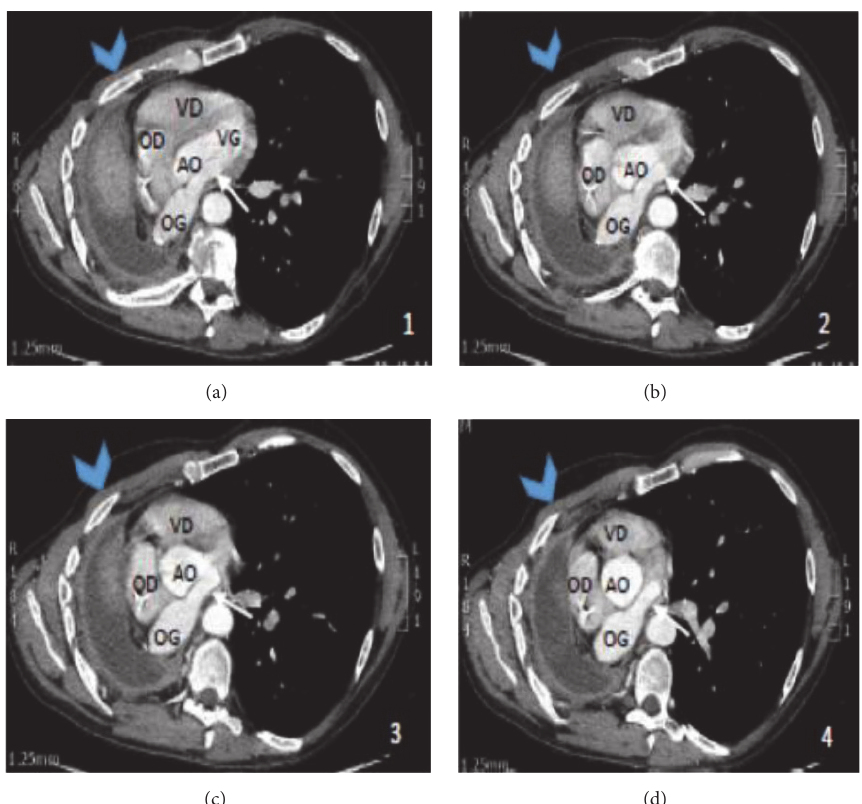
Figure 1: Thoracic computed tomography. VD, right ventricle; VG, left ventricle; OD, right atrium; OG, left atrium; AO, ascending aorta.